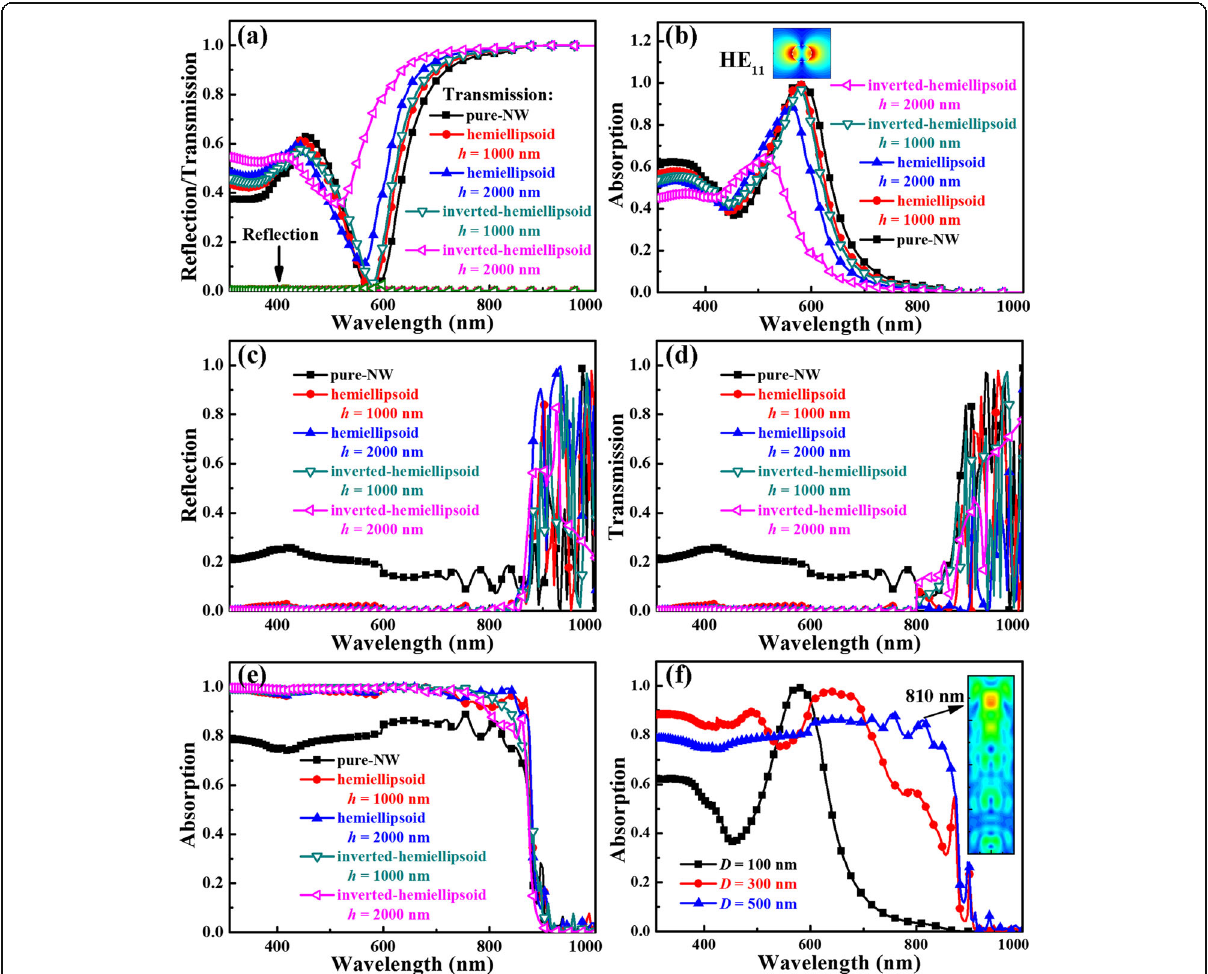
Fig. 3 a Reflection/transmission and b absorption of the arrays of H = 2000 nm and D = 100 nm. c Reflection, d transmission, and e absorption of the arrays of H = 2000 nm and D = 500 nm. f Absorption of the pure NW arrays with D of 100, 300, and 500 nm and H = 2000 nm. The inset of b shows the electric field strength distribution of the HE 11 mode, and the white dotted circle outlines the wire periphery. The inset of f exhibits the electric field strength distribution of the pure NW array with H = 2000 nm and D = 500 nm at the wavelength of 810